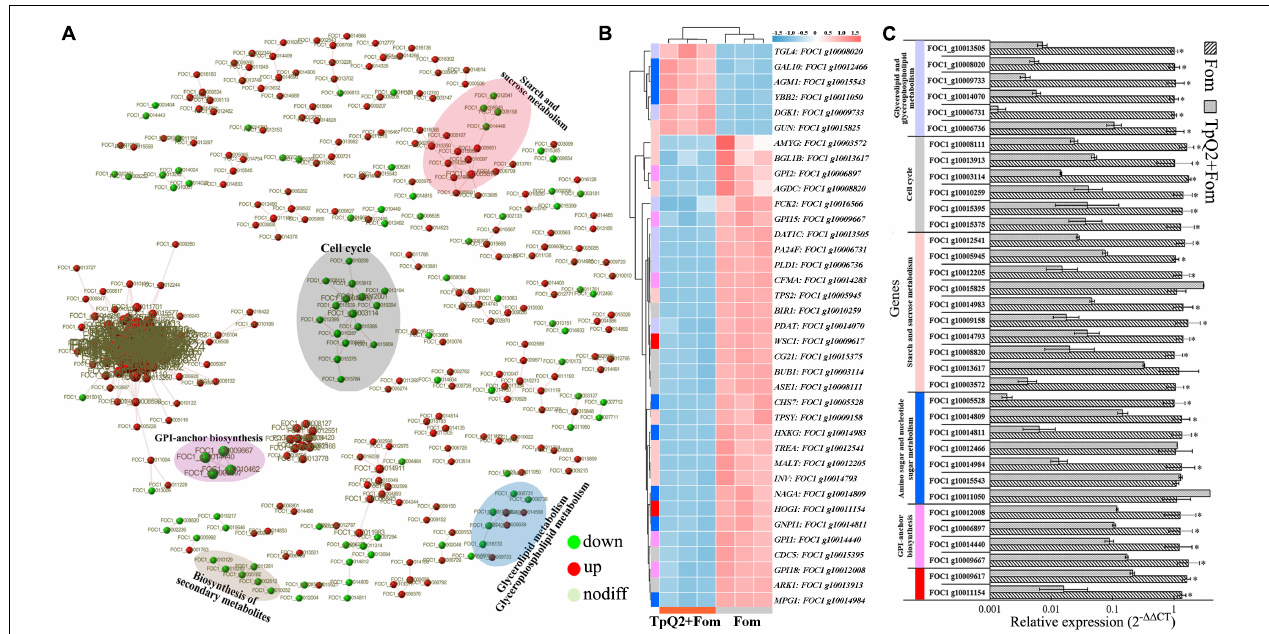
FIGURE 3 | Effects of TpQ2 on the metabolic pathways and gene expressions in Fom during co-culture. (A) Protein-protein interaction networks were constructed using by 371 differentially expressed genes (DEGs) identified in Fom based on the STRING database. (B) Expression patterns of Fom DEGs determined through RNA sequencing. (C) Quantitative RT-PCR analyses of relative expressions of selected genes. *A statistically significant difference (Student’s t -test, P < 0.05) between the two